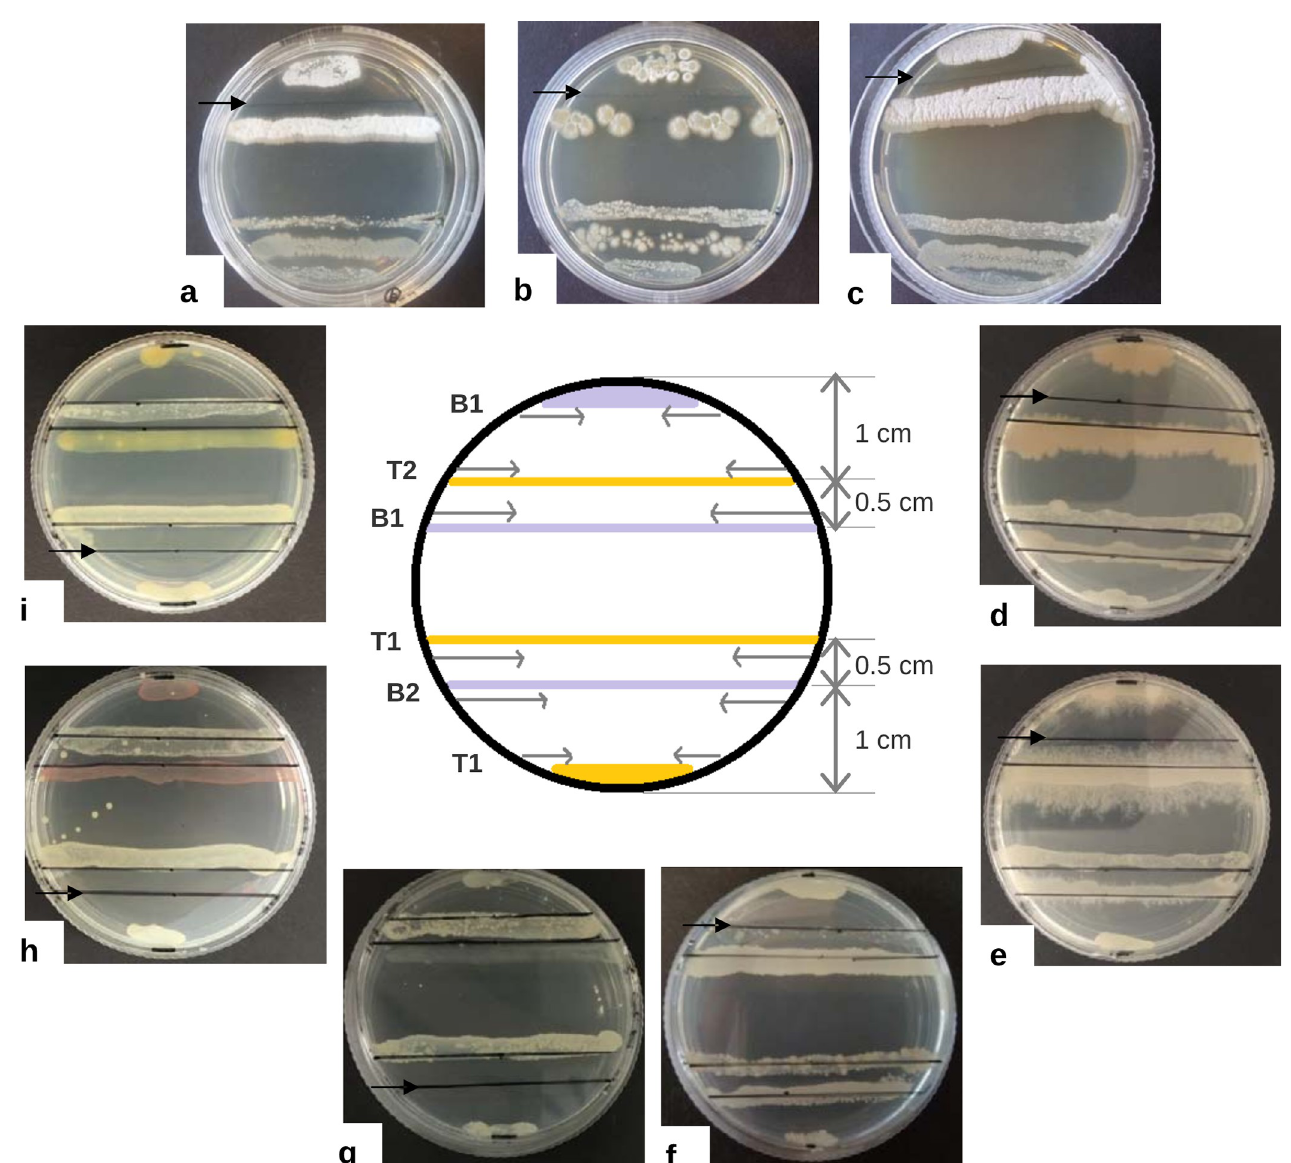
Fig 2. Examples of competition between Tsukamurella paurometabola and other bacterial isolates of the collection. Co-culture of isolate #25- T . paurometabola DSM 20162 T was performed according to the arrangement illustrated in the centre, as follows: each bacterial isolate was initially inoculated at diametrically opposite parts of a 60 x 15 mm Nutrient Agar (NA) plate. T . paurometabola was inoculated along the lines labelled T1, while the second bacterium was inoculated along the lines labelled B1. The two isolates were incubated until growth was readily visible. Subsequently, a second round of inoculation took place, with T . paurometabola inoculated along the line labelled T2 and the other bacterium inoculated along the line labelled B2. The approximate distance between those inoculated lines is indicated. Visual inspection of co-cultures took place daily, over a period of 10 d. Inoculation was performed using a sterile loop twice, and the isolates were spread along the lines in the direction indicated by the horizontal arrows. Representative results of this procedure are presented, as follows: clockwise, binary co-cultures with isolates #84- Streptomyces griseus subsp. griseus FBUA 801 (a), #87- Streptomyces sp. FBUA 1287 (b), #89- Streptomyces zaomyceticus FBUA 1571 (c), #26- Lysinibacillus sphaericus ZK38 (d), #30- Bacillus licheniformis B3 (e), #35- Bacillus siamensis D9 (f), #16- Sphingomonas sanxanigenens DSM 19645 T (g), #53- Hydrogenophaga carboriunda TV-122 (h) and #74- Rhodanobacter lindaniclasticus RB3-4A (i). The photographs were taken 7 d after incubation of the co-cultures and the black arrows indicate the inoculation line of the inhibited isolate. T . paurometabola is inhibited by the Actinobacteria (a-c) and the Firmicutes (d-f), but inhibits the Proteobacteria (g-i).